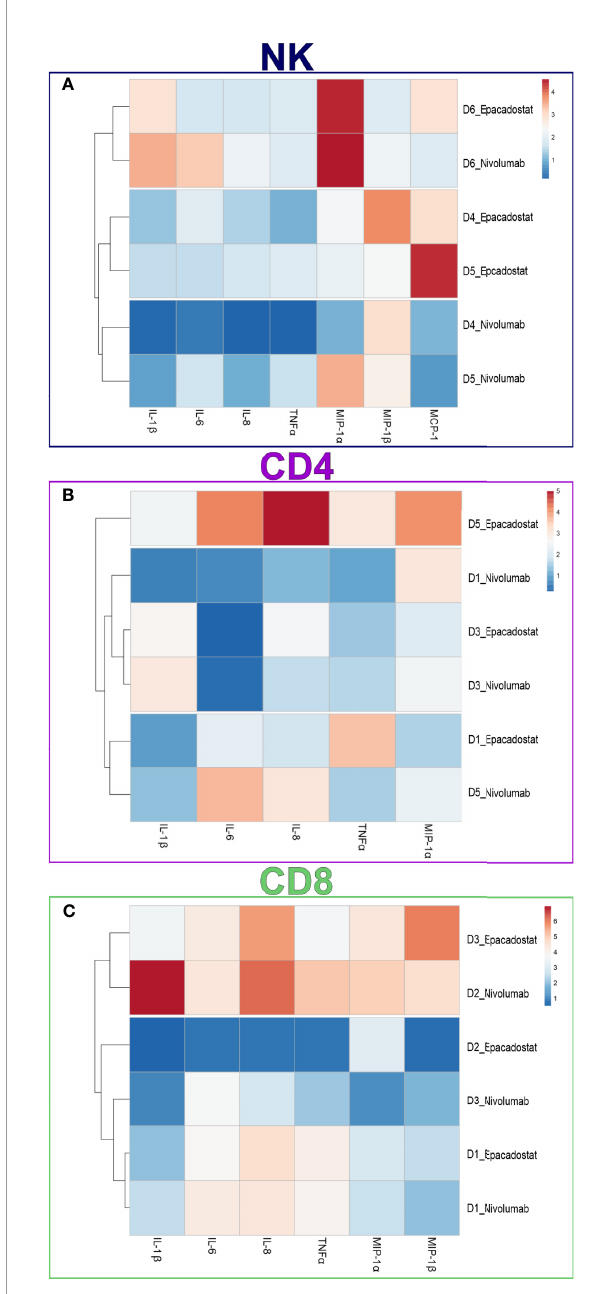
FIGURE 5 | Cytokine expression in the conditioned media of NK, CD4 + , and CD8 + T cells. Cytokine concentrations in the conditioned media were measured using a FirePlex ® -96 Key Cytokines (Human) Immunoassay Panel. Cytokine concentrations were plotted in the heatmaps as fold change from control (HSC-3 alone). Heatmap of NK cells (A) showed apparent clustering for the ICIs epacadostat and nivolumab, with donor six showing donor variance. Heatmaps of the CD4 + T cells (B) and CD8 + T cells (C) did not show clustering based on ICI group. The experiments were repeated three times, each time using a different donor and each in duplicate. NK, natural killer cell; CD4, CD4 + T cells; CD8, CD8 + T cells; D, donor; IL-1 b , interleukin 1-beta; IL-6, interleukin 6; IL-8, interleukin 8; MCP-1, monocyte chemoattractant protein-1; MIP-1 a , macrophage in fl ammatory protein 1 alpha; MIP-1 b , macrophage in fl ammatory protein 1 beta; TNF a , tumor necrosis factor-alpha